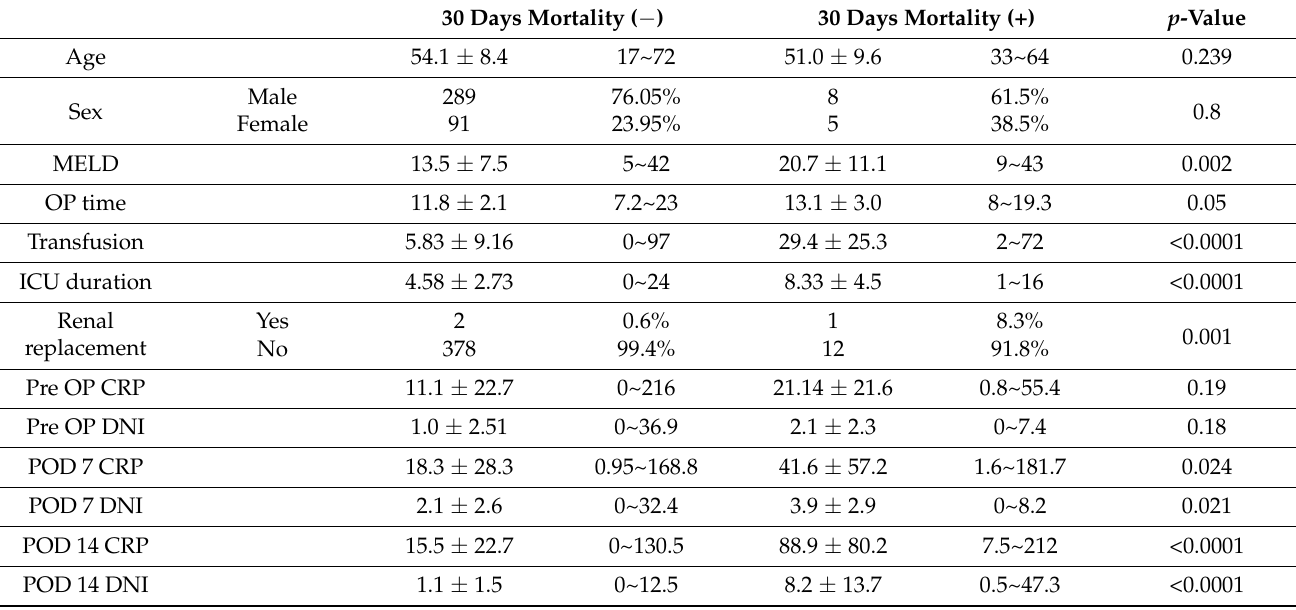
Table 1. The characteristics of the study population. 30 Days Mortality ( − ) 30 Days Mortality (+) p -Value 54.1 ±